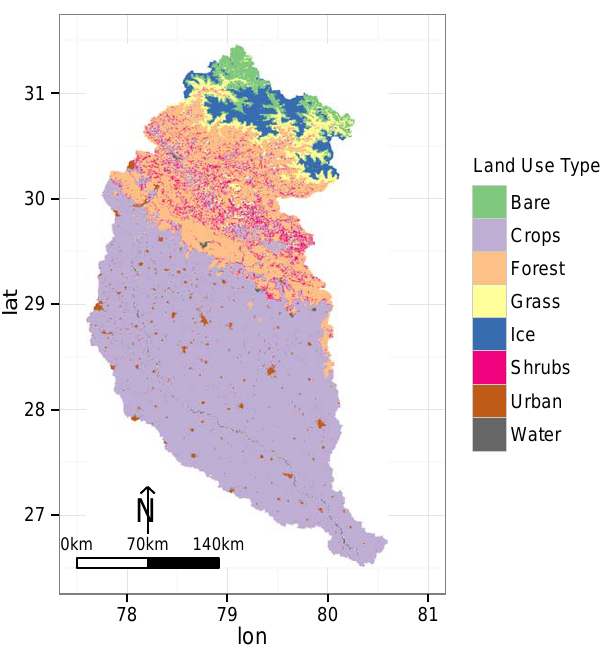
Figure 2. Land cover map for year 2000, as developed by Tsarouchi et al.